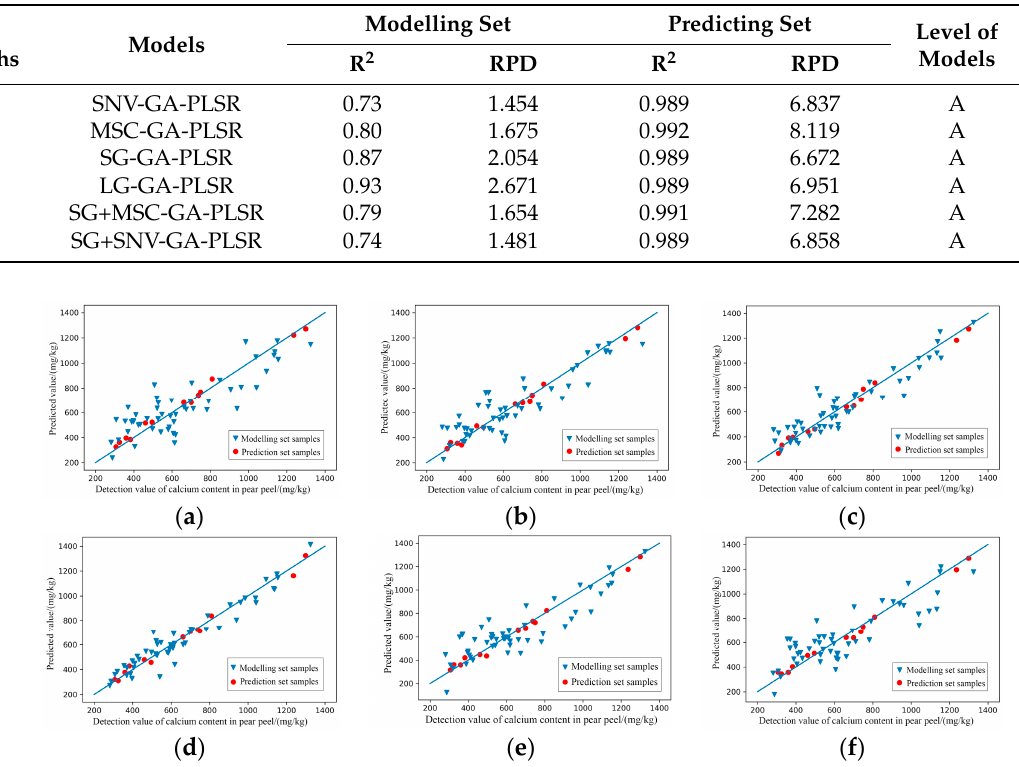
Table 7. Modelling prediction results of the content of calcium in pear peel based on the selected characteristic wavelengths.